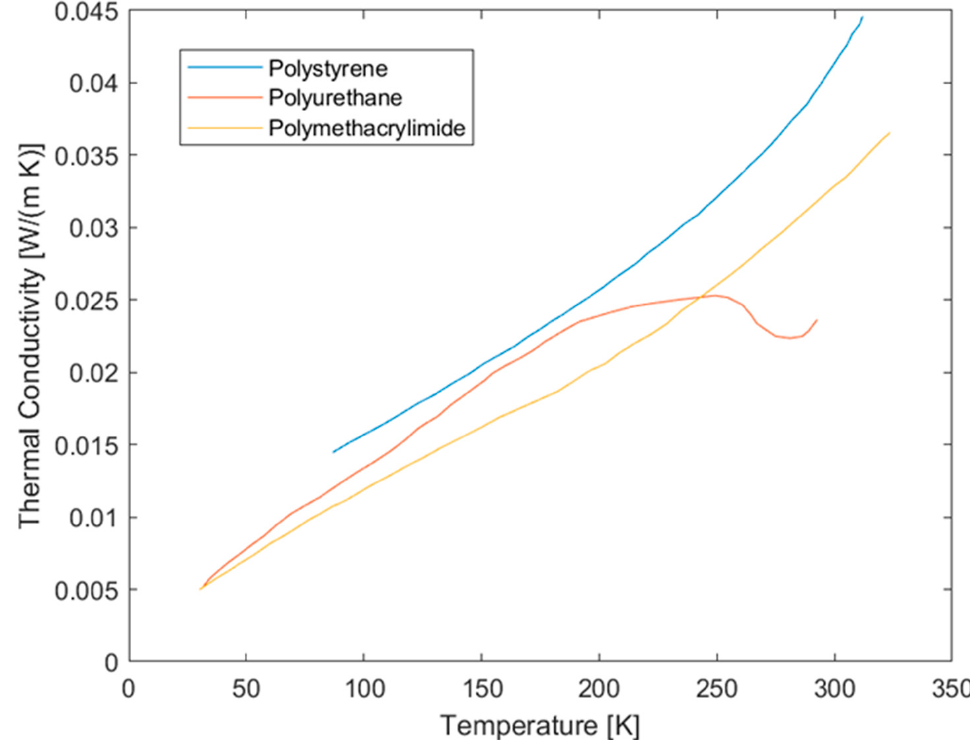
Figure 4. Thermal conductivity of insulation foams.